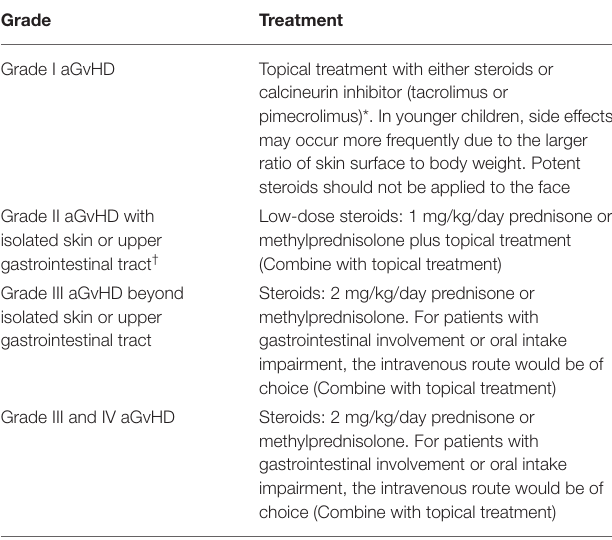
TABLE 3 | Suggested first-line treatment of aGvHD in